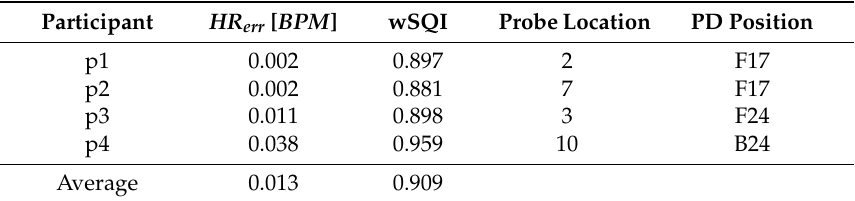
Table 2. LED-PD pairs yielding minimal HR errors in the direct-contact foot PPG experiment. Participant HR err [ BPM ] wSQI Probe Location